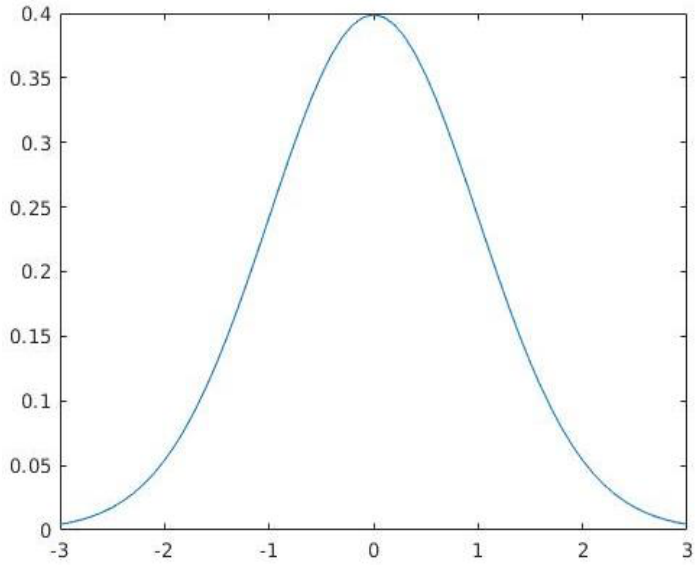
Figure 4. Density plot for Gaussian distribution.